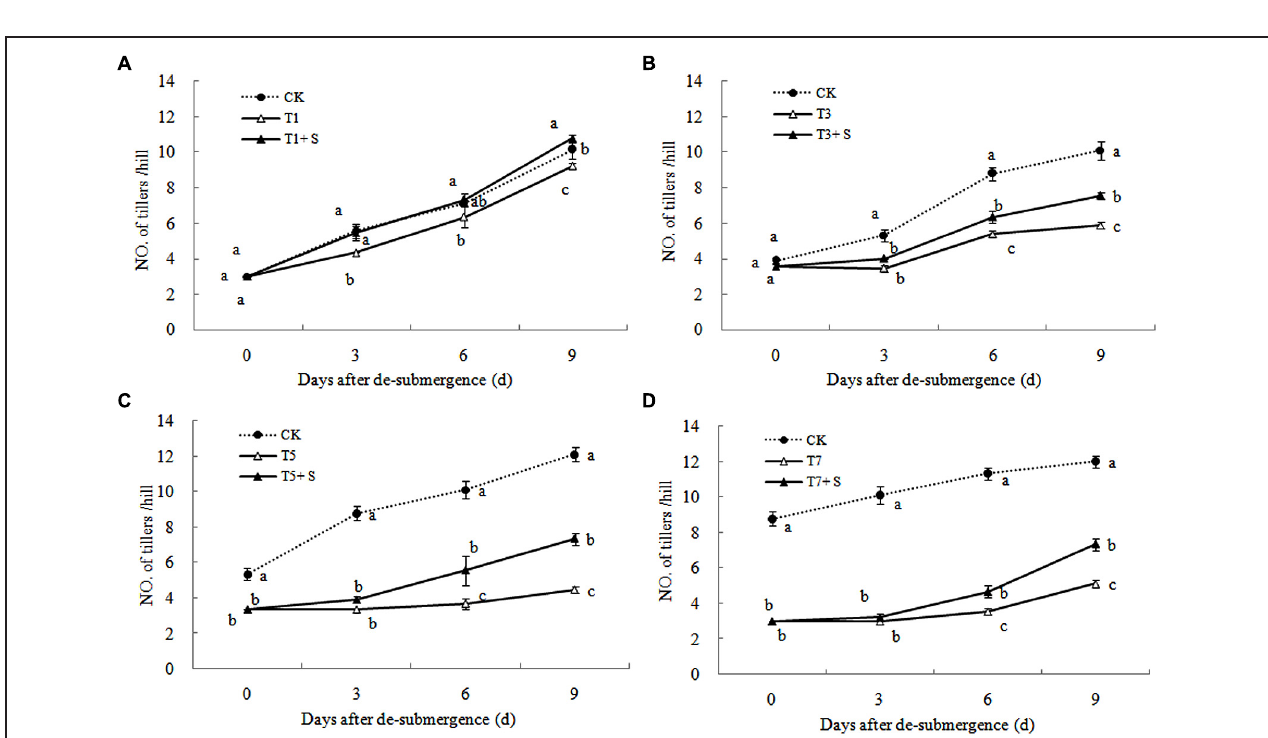
FIGURE 2 | Effects of Spd on tillers number per hill of rice after submergence.